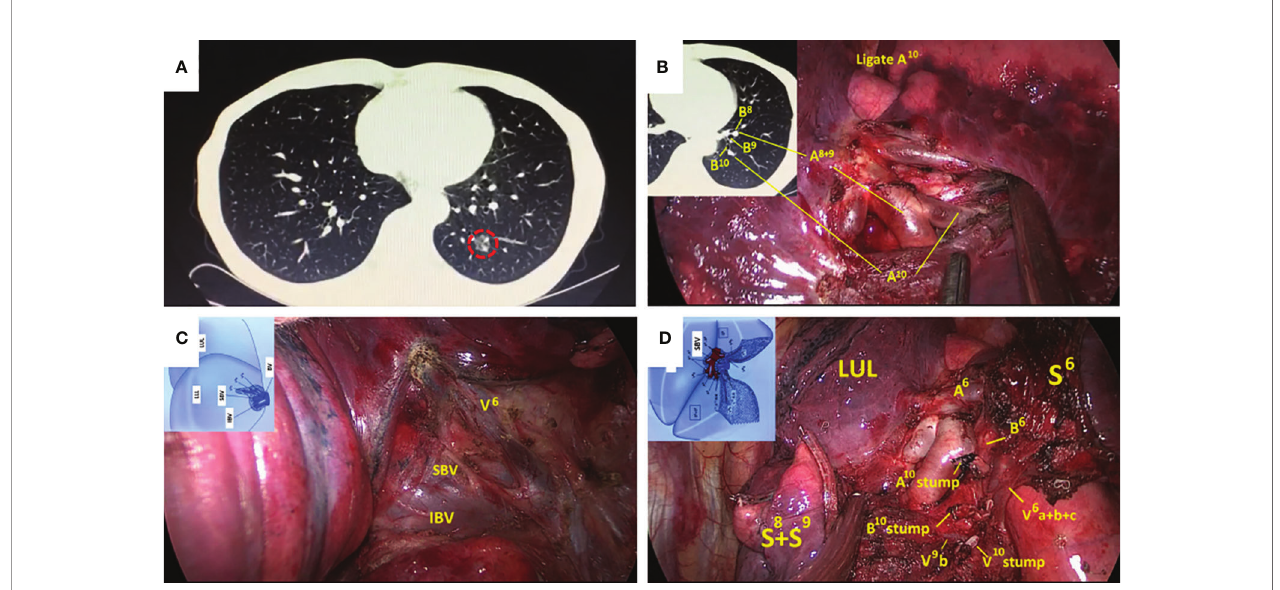
FIGURE 2 | Routine left S 10 segmentectomy based on CT scan and normal anatomic characteristics. (A) CT scan showed a GGOs lesion in the left S 10 ; (B) The branches of the pulmonary artery exposed in the VATS were consistent with CT. (C, D) Surgical details were compared with segmental atlas written by Hiroaki Nomori and Morihito Okada. CT, computed tomography; VATS, video-assisted thoracoscopy; GGOs, ground-glass opacities.